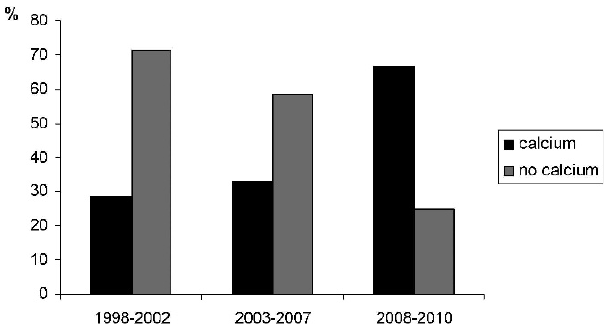
Figure 7 - Numbers (%) of patients with hyperparathyroidism/ multiple endocrine neoplasia type 1 requiring calcium supple- ments according to time elapsed since the initial treatment (1998 to 2010).